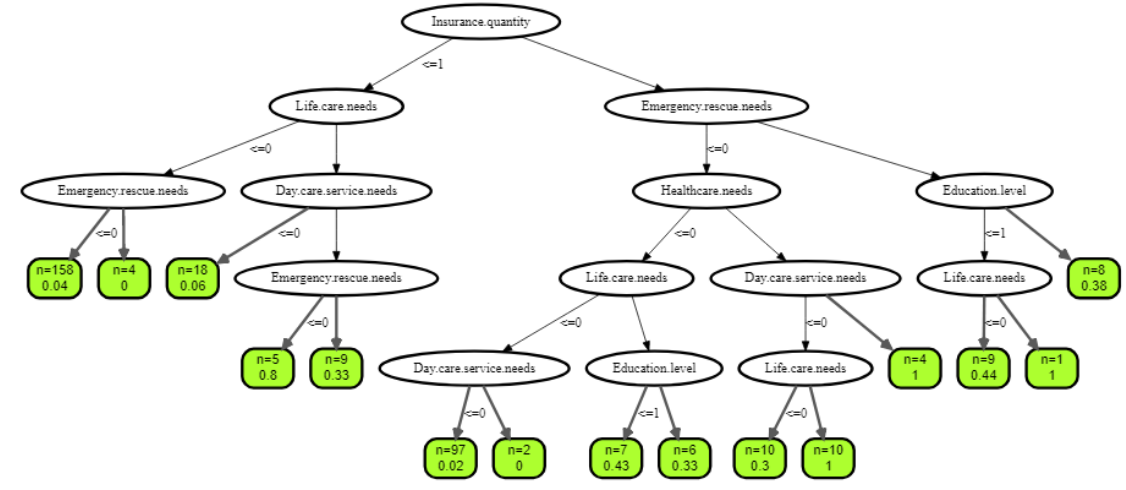
Figure 6. Random forest dendrograms.